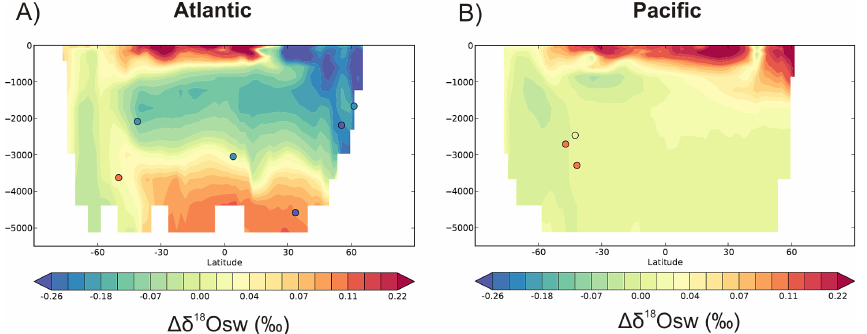
Figure 12. (a) Atlantic and (b) Pacific zonal mean anomaly (LGM-CT) for simulated deep water δ 18 O in i LOVECLIM and water δ 18 O in pore fluids of deep-sea sediments (Adkins et al., 2002; Schrag et al., 2002; Malone et al., 2004). A correction of the LGM ice sheet contribution (1‰) has been applied. For colour scale generation explanations see Fig. 1